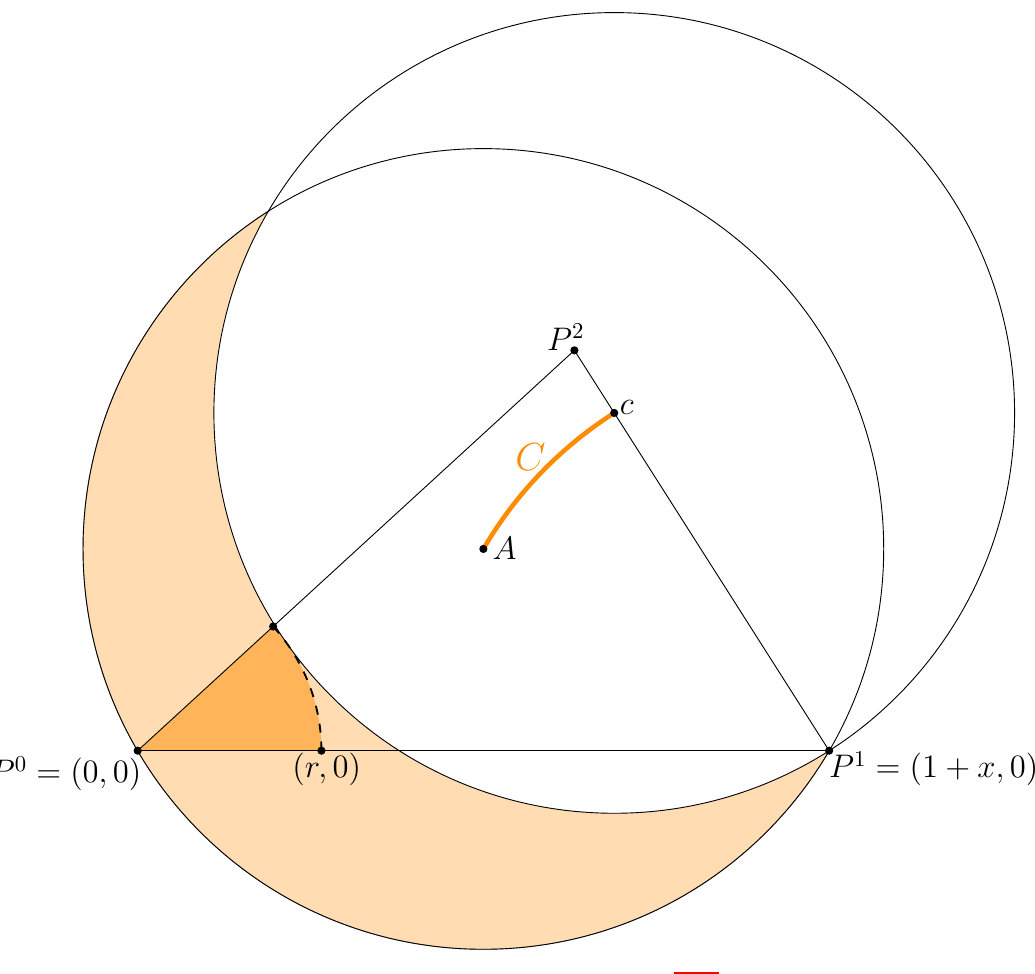
Figure 2: Reaching the corners of a triangle as in Lemma 3.2. To reach any point Q in the shaded are within T from A , take one step to P 1 , then one to a point on the arc C , and finally to Q . There exists a suitable point on C because the shaded area lies in B 2 ( A, 1) \ B 2 ( c, 1) and C is a continuous path from c to A